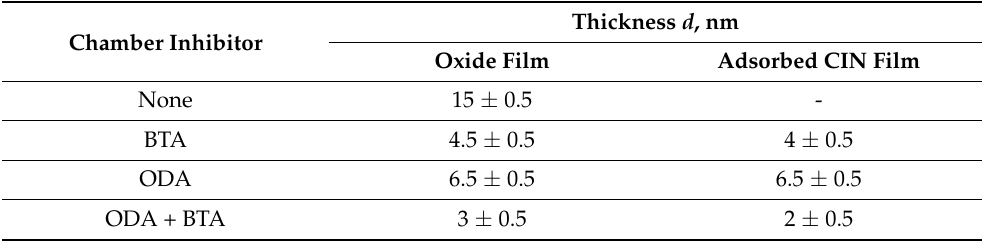
Table 4. Effect of steel chamber treatment on the thickness d of surface films. T CT = 120 ◦ C, τ CT = 1 h. Chamber